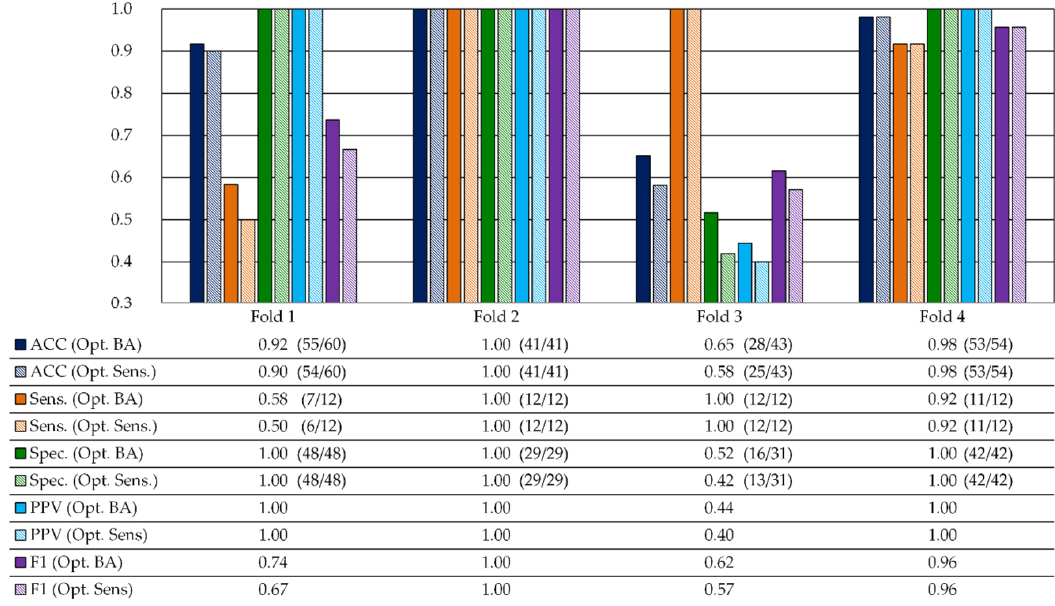
Figure 11. Average image classification results of each fold in the validation set using both metrics (BA